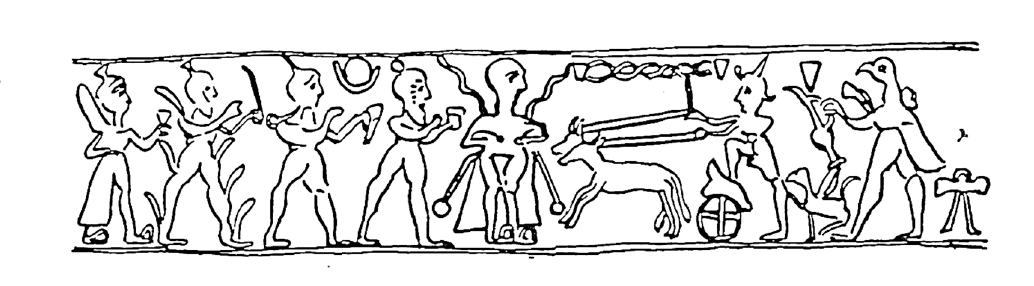
Figure 10. Hittite seal: Disrobing goddess facing the god riding his chariot, guilloche between (Leinwand 1992: Figure